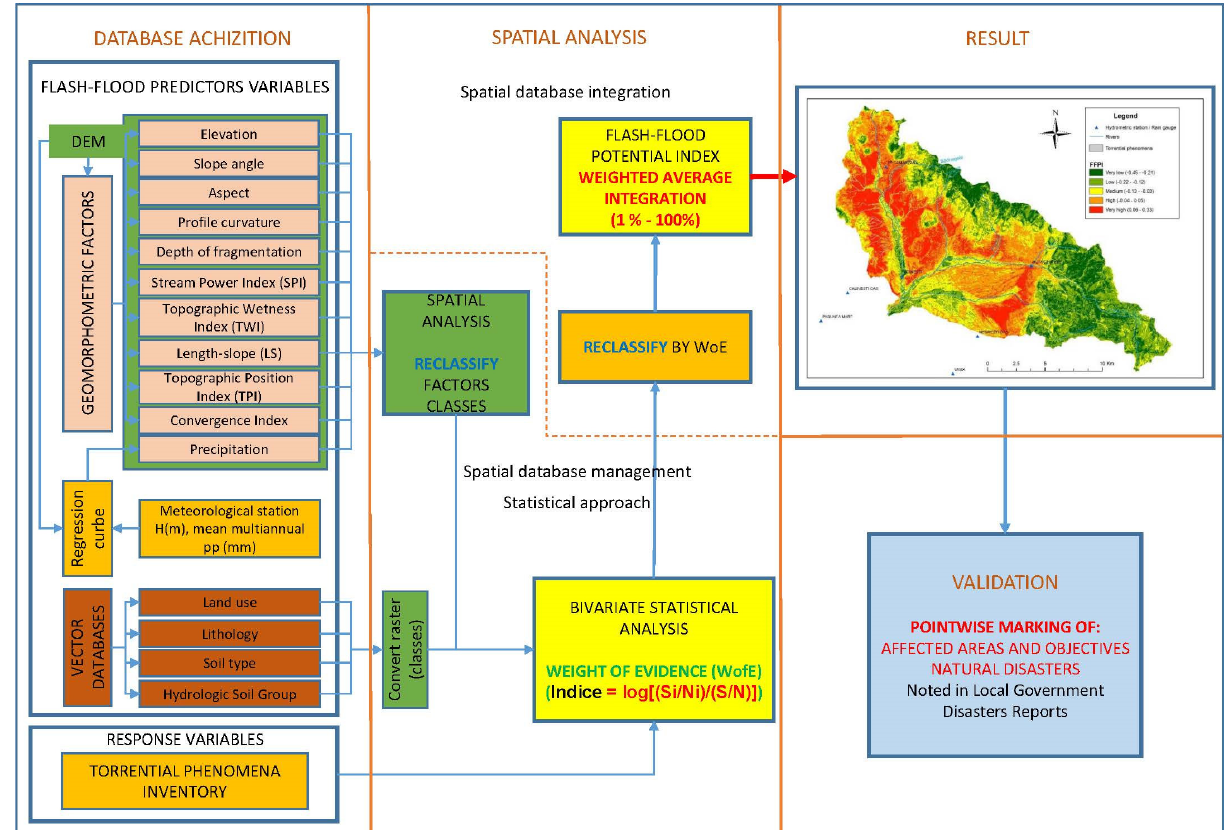
Figure 2. Flowchart of the methodology.